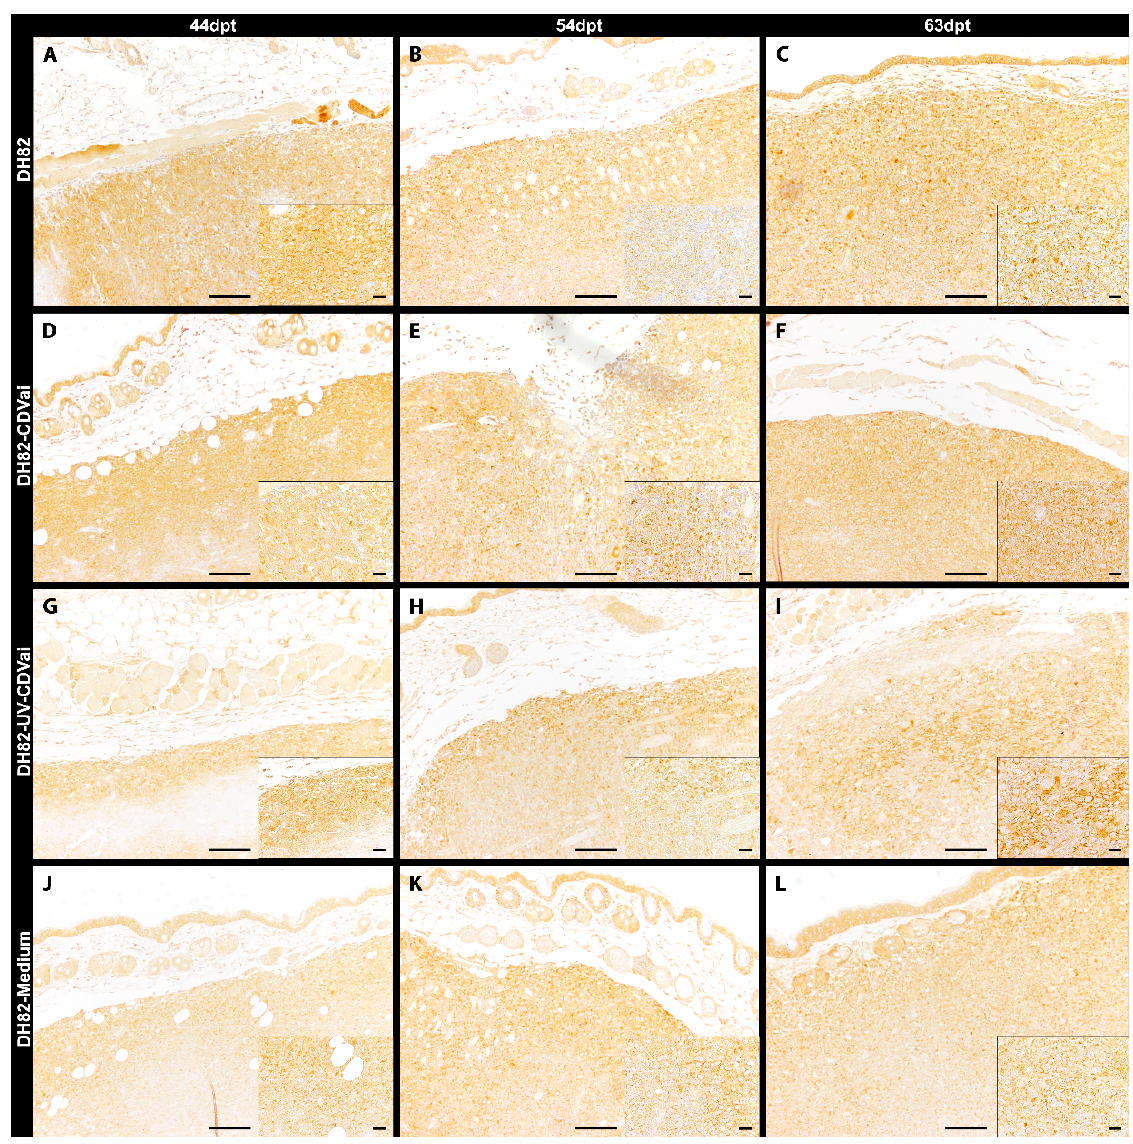
Figure 5. Peripheral MMP-2 immunolabeling in murine subcutaneous DH82 cell xenografts ( A – L ). ( A – C ) display non- infected (DH82), ( D – F ) intratumorally canine distemper virus (CDV)-infected (DH82-CDVai), ( G – I ) intratumorally UV- inactivated CDV-injected (DH82-UV-CDVai) and ( J – L ) intratumorally medium-injected (DH82-medium) neoplasms at ( A , D , G , J ) 44 days post-transplantation (dpt), ( B , E , H , K ) 54 dpt and ( C , F , I , L ) 63 dpt. Scale bar = 100 μ m and scale bar— insert = 20 μ m.